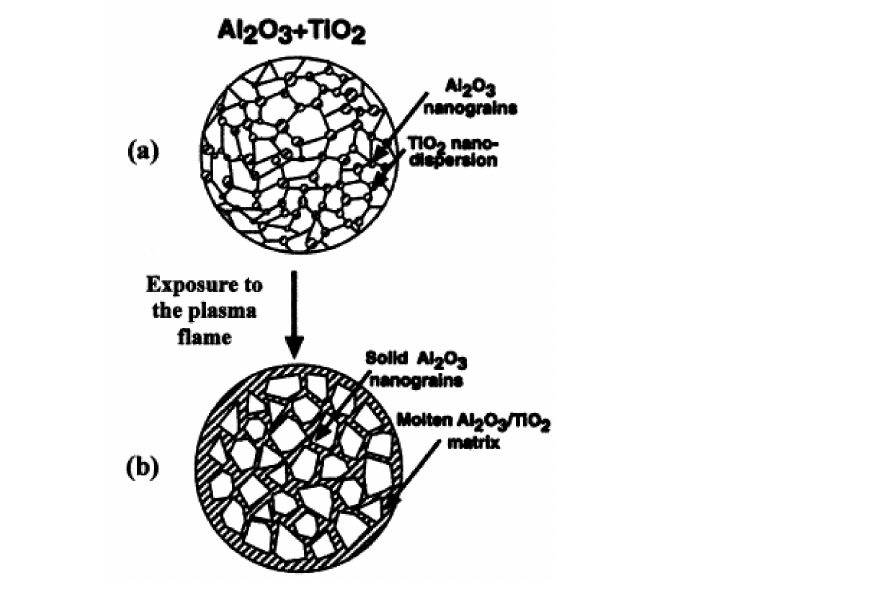
Figure 6. Substrates depicting ( a ) unexposed Al 2 O 3 -TiO 2 nanograins and ( b ) morphology of Al 2 O 3 - TiO 2 when exposed to plasma